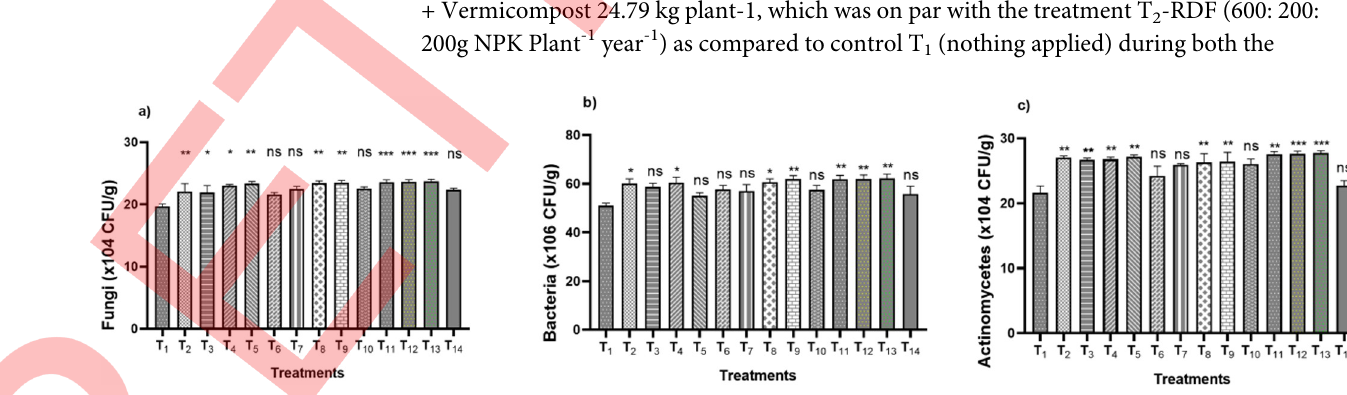
Fig 3. The effect of different organic manure treatments on soil microbial populations, where ( a ) Fungi; ( b ) Bacteria; ( c ) Actionmycetes. Various asterisk on bars show the significant differences ( P < 0.05) with vertical bars as standard errors ( n = 4) ( ���� > ��� > �� > � > ns).